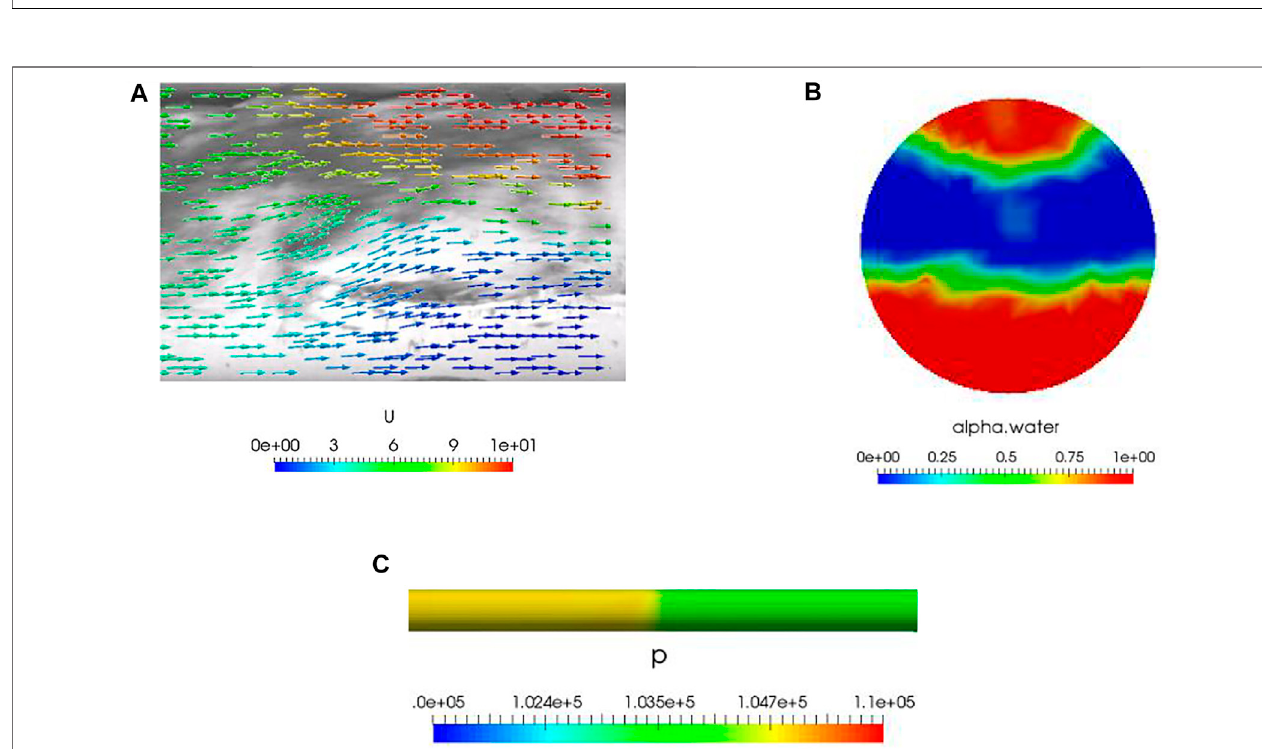
FIGURE 15 | (A) Comparison between experimentally obtained slug head image and simulated velocity vectors. (B) Distribution of liquid holdup in the pipe cross- section. (C) Pressure distribution in the pipe before and after the slug.